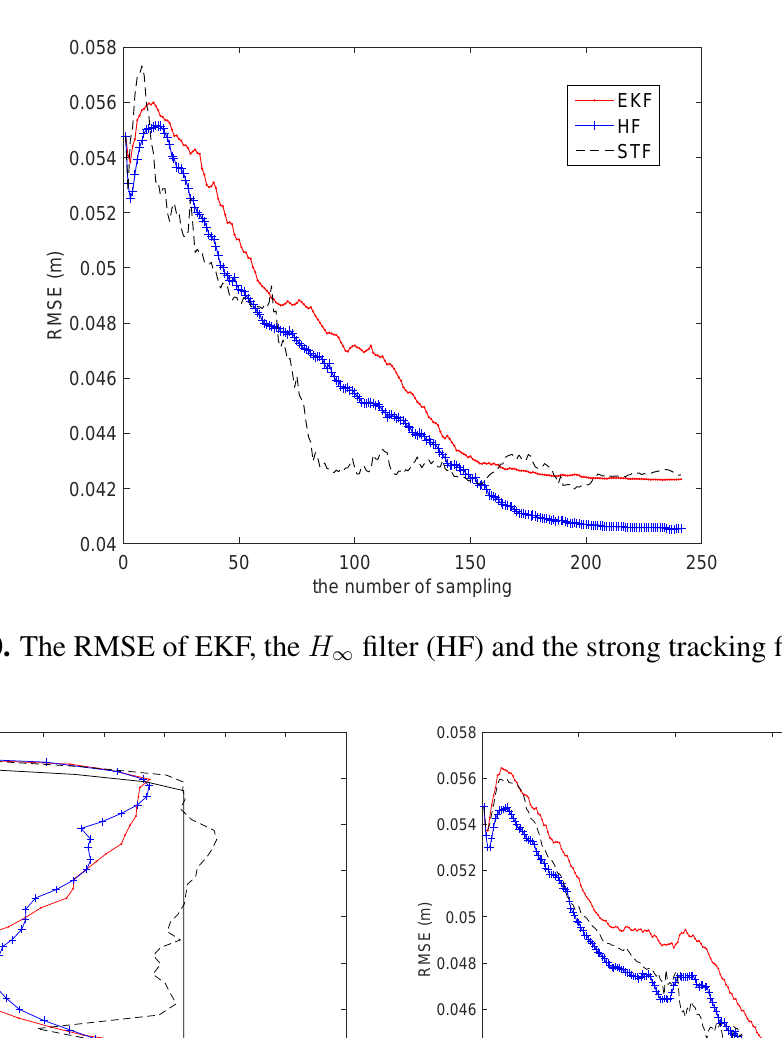
Figure 11. The impact of noise. ( a ) The tracking with noise; ( b ) the